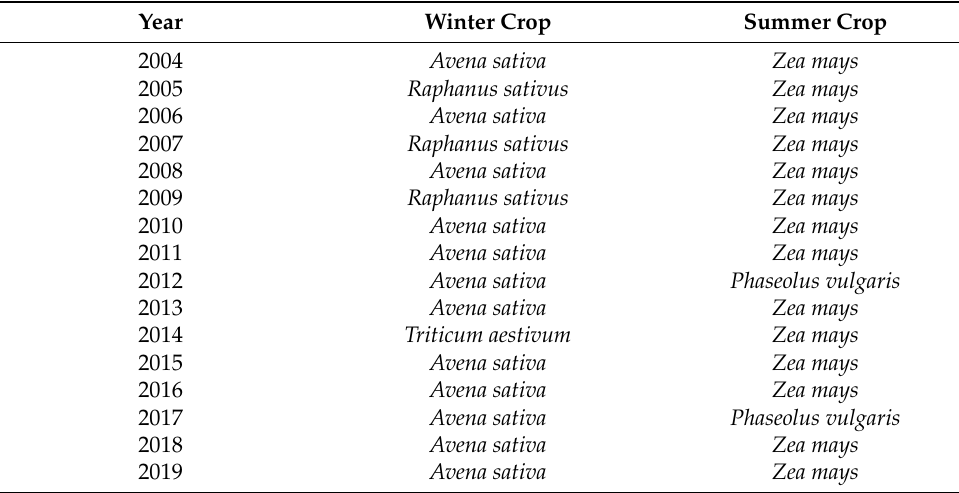
Table 1. Crop sequence throughout the long-term